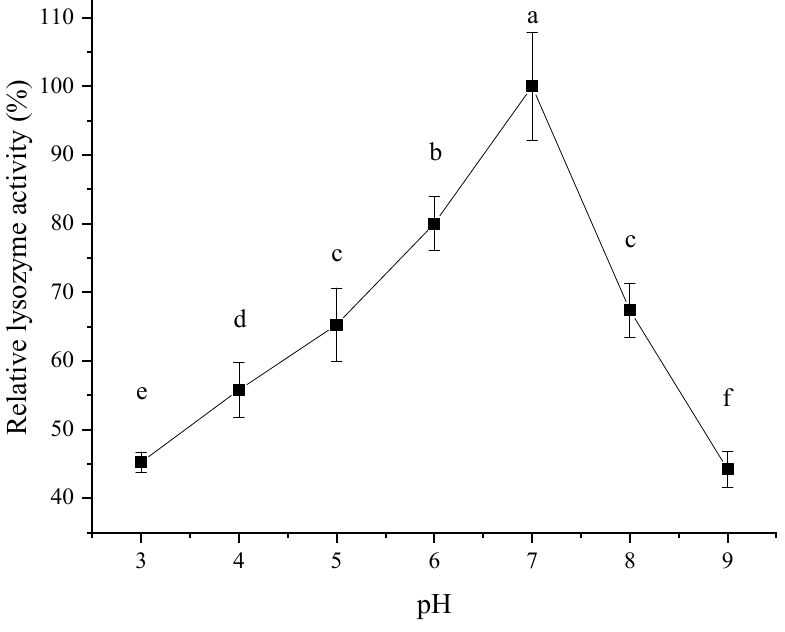
Figure 7. Effect of pH on activity of lysozyme from SDEW.